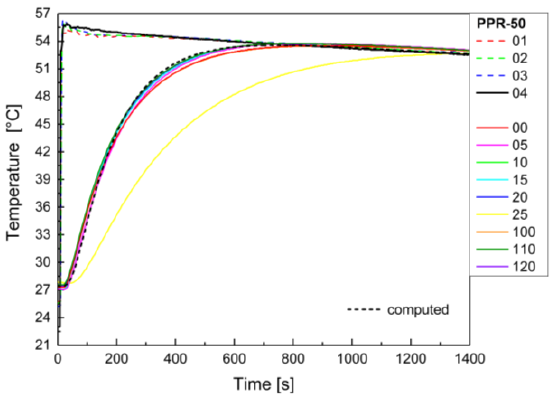
Figure 13. Time-history of measured temperatures and the temperatures computed in the probe axis (measurement A — water bath temperature of 55 °C/probe 1).